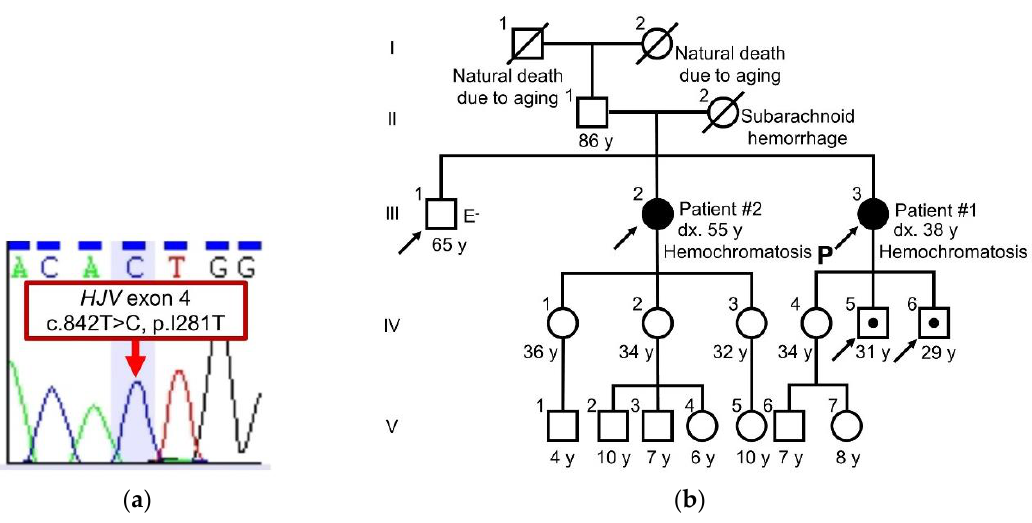
Figure 1. The sequence analysis of HJV exon 4 of the proband (patient #1) and the family tree. The homozygous missense mutation c.842T >C, p.I281T (red arrow) is shown. ( a ). The proband (P: patient #1) and the elder sister (patient #2) developed hemochromatosis, while the other family members showed no manifestations of hemochromatosis. ( b ). III-2 and -3, HJV I281T / I281T; IV-5 and -6, HJV I281T / -. Arrows represent individuals who received a genetic analysis. Table 1. Characteristics of patients with homozygous I281T mutations in HJV ( HFE2 ): the current and reported cases.